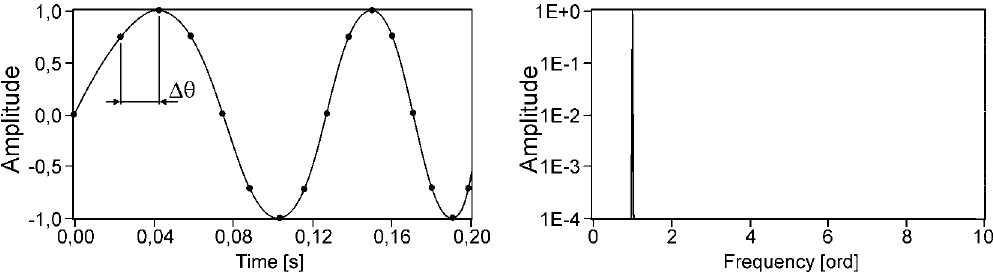
Fig. 2. Waveform and order spectrum of a rotor’s variable speed vibration sampled using constant increments of shaft